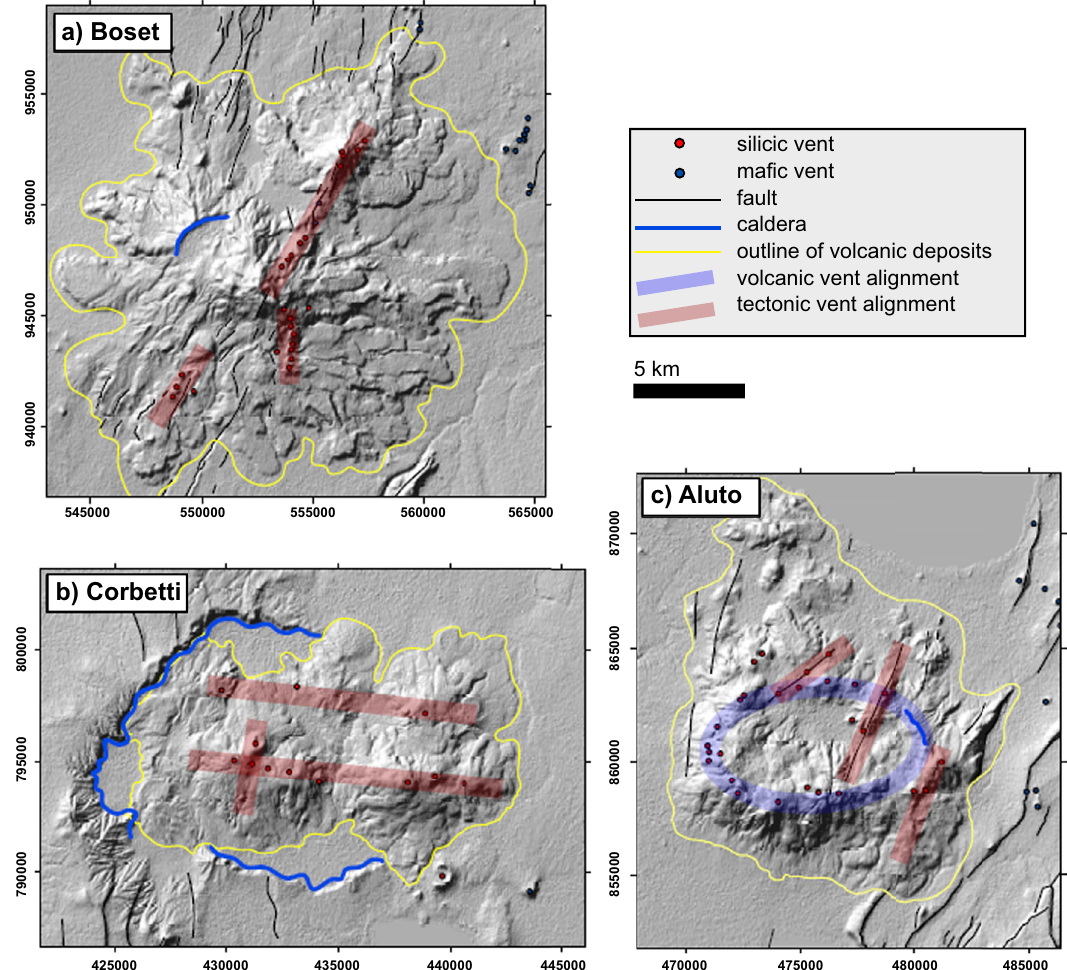
Fig. 4 Contrasting examples of the structural controls on post-caldera volcanism. Structural controls are identi fi ed by vents, domes and craters in the Main Ethiopian Rift (adapted from ref. 111 ). Volcano locations shown on Fig. 1a. a at Boset, trends in vent locations are rift-parallel, aligned with regional faults surrounding the edi fi ce; b at Corbetti, post-caldera volcanism is aligned with a pre-existing cross rift structure 84 , c at Aluto, vents and craters follow a proposed caldera rim fault 82 , which has now been buried by subsequent